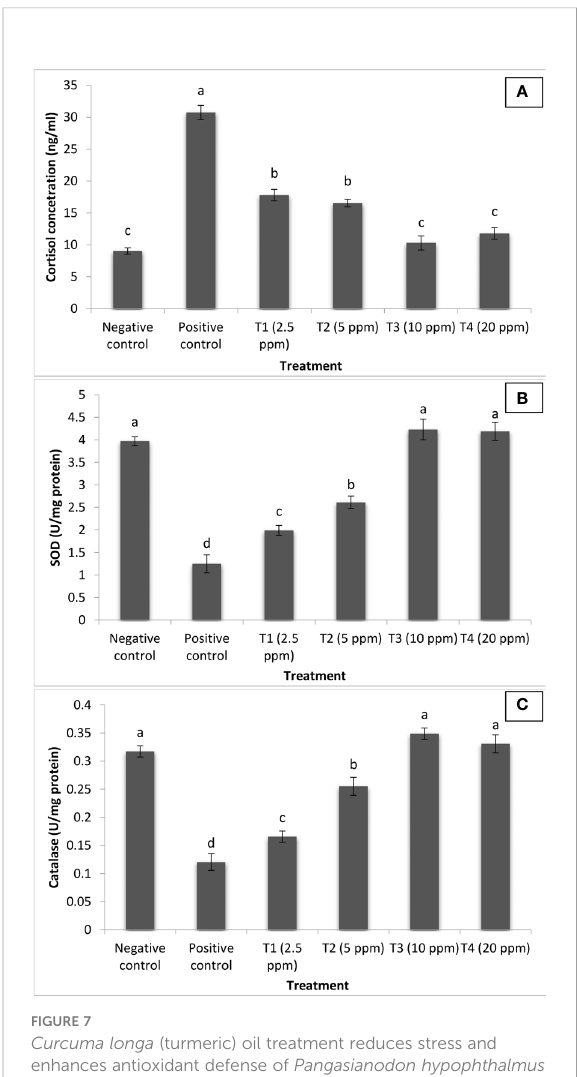
FIGURE 7 Curcuma longa (turmeric) oil treatment reduces stress and enhances antioxidant defense of Pangasianodon hypophthalmus fi ngerlings against I. multi fi liis and A. hydrophila co-infection. The serum samples of P. hypophthalmus fi ngerlings were collected from six treatment groups. The fi ngerlings in T1 – T4 groups were treated with oil extract at the indicated doses. Non- pretreated larvae that were either co-infected (positive control) or not (negative control) served as controls. (A) Cortisol concentration (ng/ml); (B) superoxide dismutase (SOD) activity (U/mg protein); and (C) catalase (CAT) activity (U/mg protein). Error bars represent the standard error of fi ve replicates; different letters indicate signi fi cant differences between treatment groups ( p < 0.001).